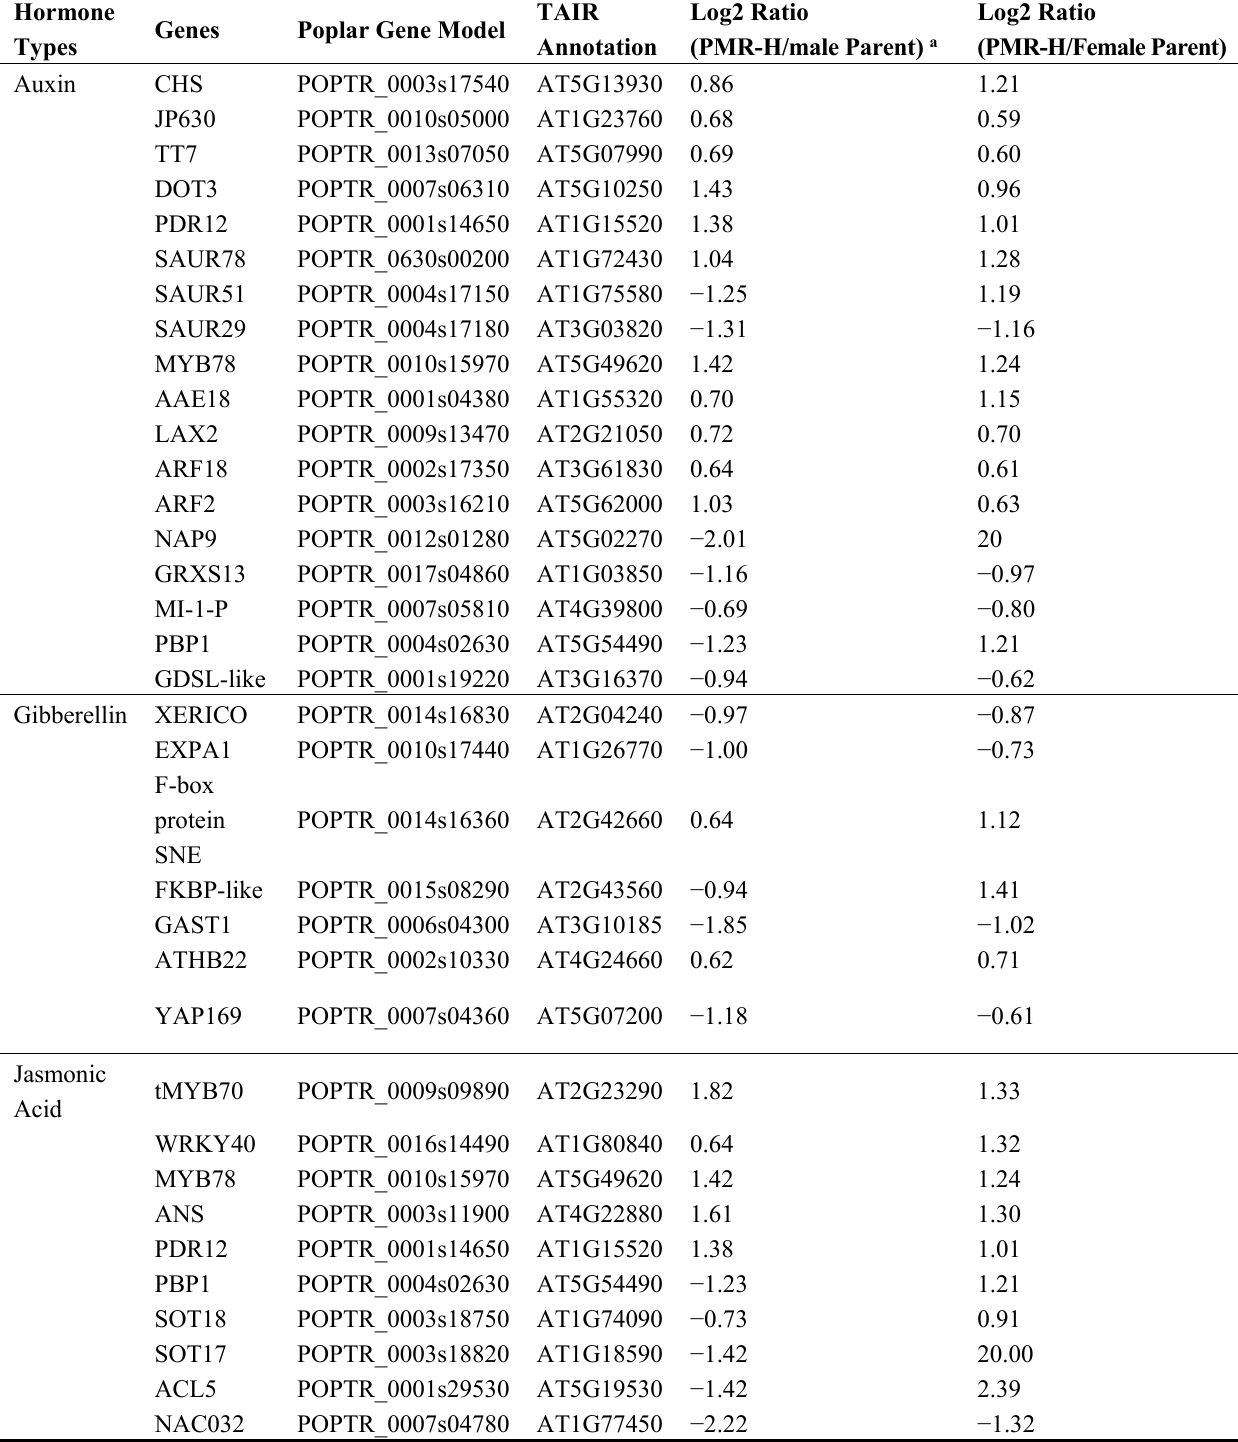
Table 4. Hormone-related genes preferentially expressed in high-growth allotriploid Populus progeny genotypes (PMR-H) compared to their diploid